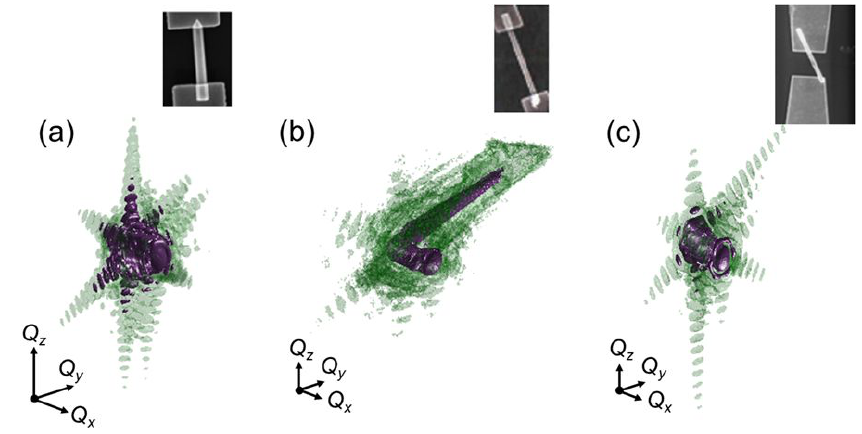
Figure 5. Comparison of the intensity distributions around 10¯10 GaN NWs Bragg peak for the different types of Au contacts. ( a , b ) The contacts deposited on the top of the nanowires with the diameters of 350 nm ( a ) and 200 nm ( b ). ( c ) The intensity distribution for a NW with the diameter of 200 nm contacted on the top of the Au electrodes by melting procedure. For all types of the contacts, a significant influence on the scattered X-ray intensity due to the induced strain during the contacting process could be seen. To enhance the diffraction pattern details, the intensity distributions are represented by two different iso-surfaces. The length of coordinate arrows corresponds to 0.1 nm − 1 . The intensity is normalized to the maximum and the iso-surface values are 10 − 3.5 and 10 − 4.5 ( a ), 10 − 1.5 and 10 − 2.85 ( b ), 10 − 2.5 and 10 − 3.5 ( c